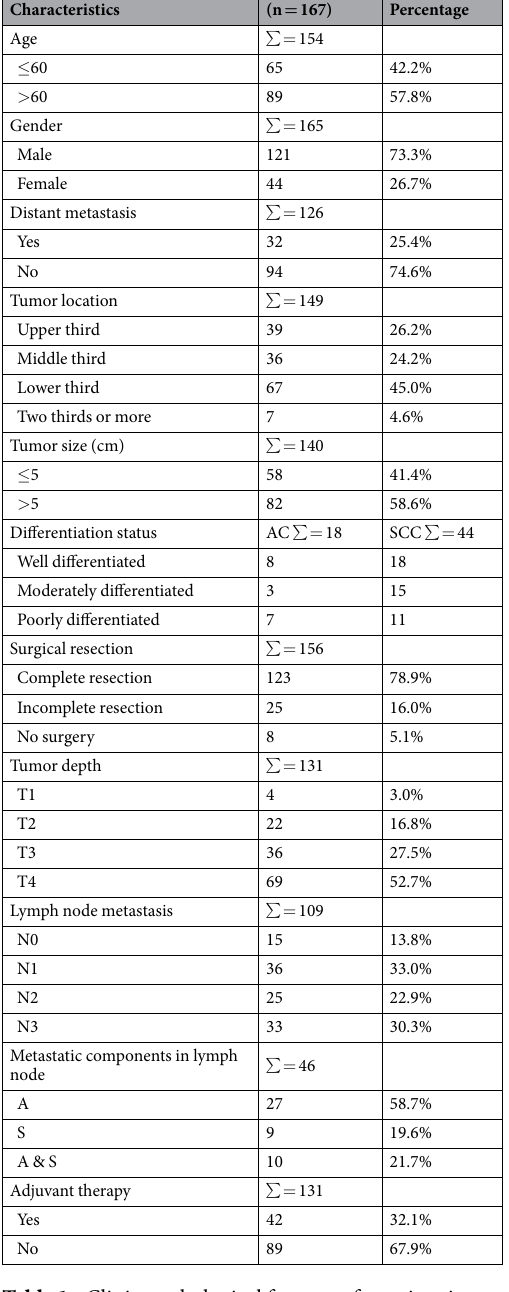
Table 1. Clinicopathological features of gastric primary